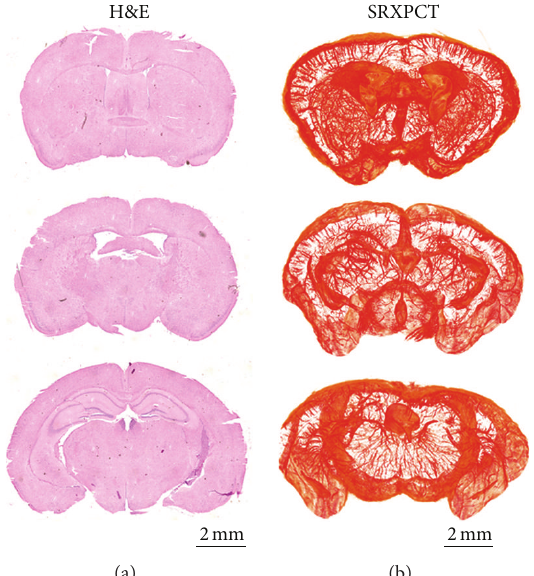
Figure 6: Comparison of H&E staining (a) and reconstructed sections of 3D SRXPCT (b) of mice brains.